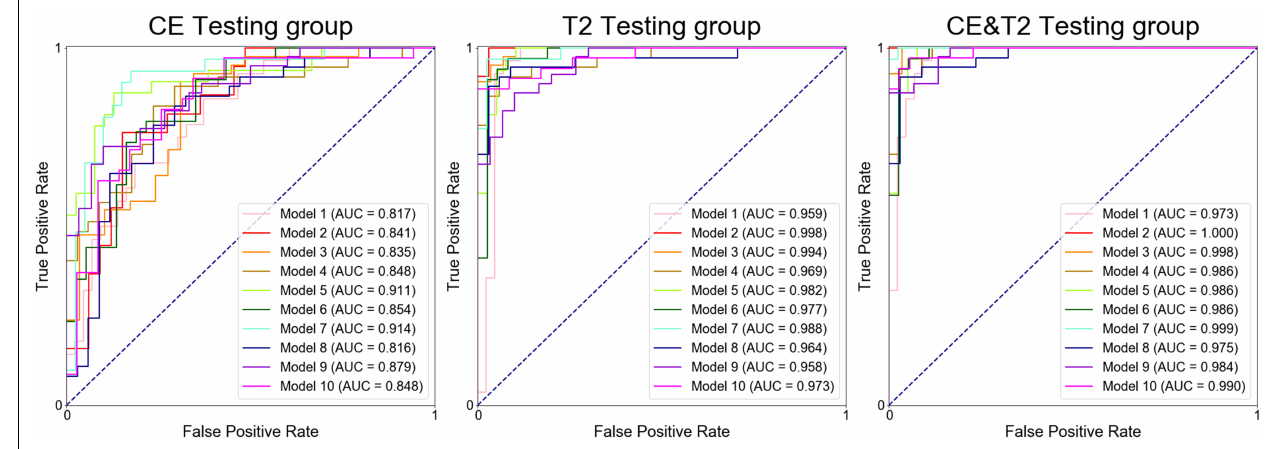
FIGURE 3 | Receiver operating characteristic curves for the models during the corresponding testing groups.